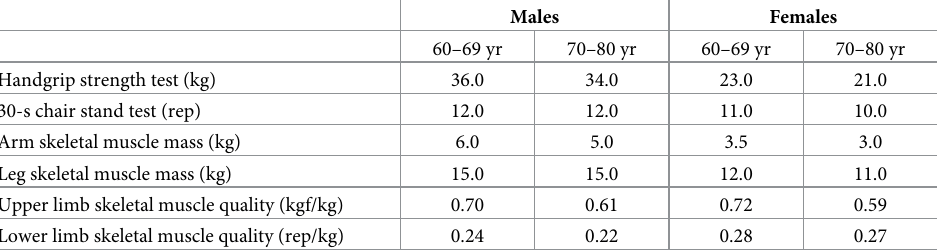
Table 2. Cut-offs for upper and lower limb measures to identify older adults with low skeletal muscle strength, muscle mass, and muscle quality according to sex and age group.